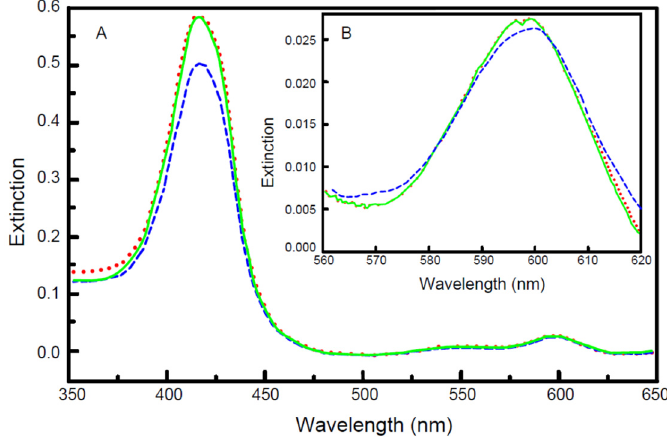
Figure 1. Absolute UV-VIS absorption spectra (maximum at 421 nm) of isolated cholate-bound CytOx from bovine heart. The 3 µ M CytOx concentration was dissolved in 50 mM potassium phosphate, 1 mM EDTA, pH 7.4 and 1% Tween 20. Samples were incubated for 24 h at 0 ◦ C with 5 mM ATP, or 5 mM ADP, or without nucleotides. The measured absorption spectrum without nucleotides is a continuous line in green while in the presence of ATP is the dotted line in red and that of ADP is a broken line in blue.